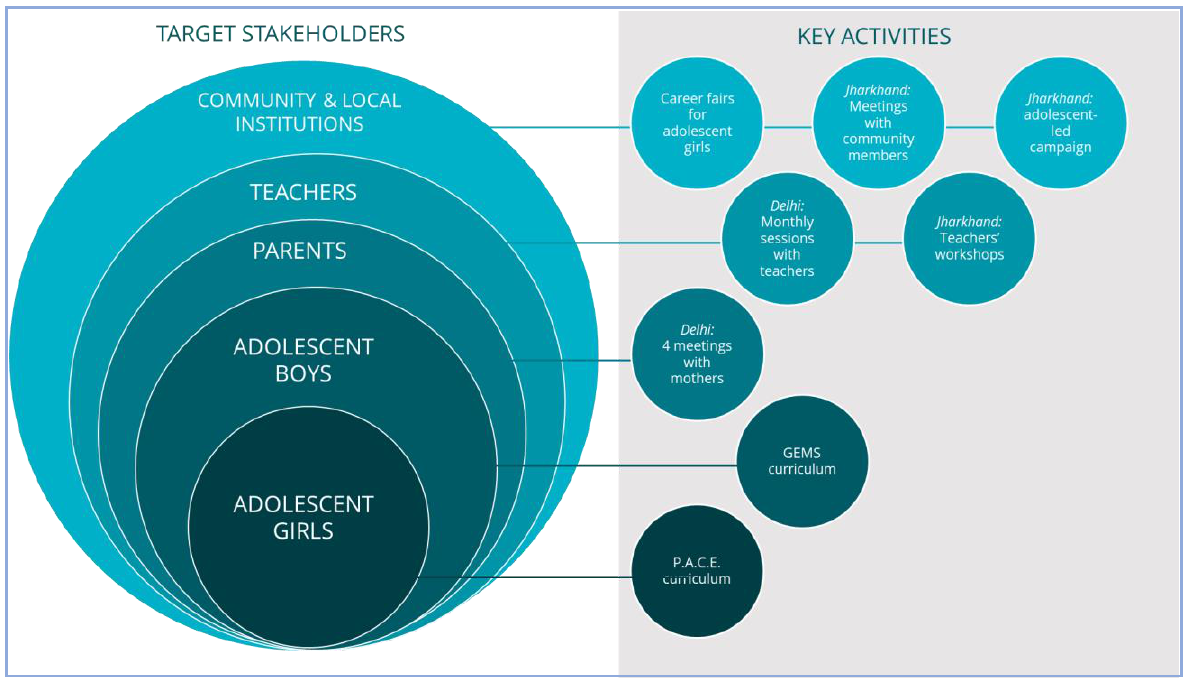
Figure 1: Key Program Activities for the